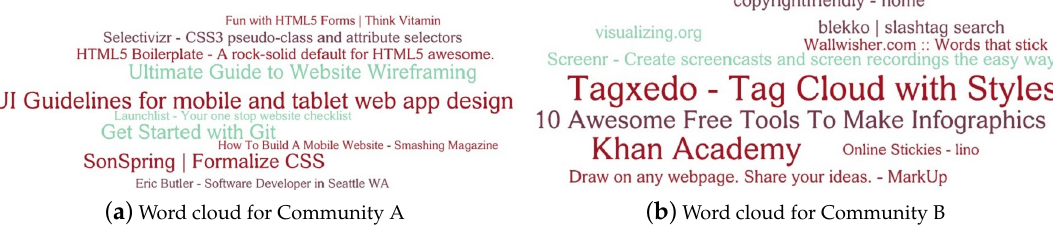
Figure 9. Word clouds for different communities detected by NMLPA. Top ten attributes of these communities are displayed here. The size of the word is proportional to its frequency in corresponding